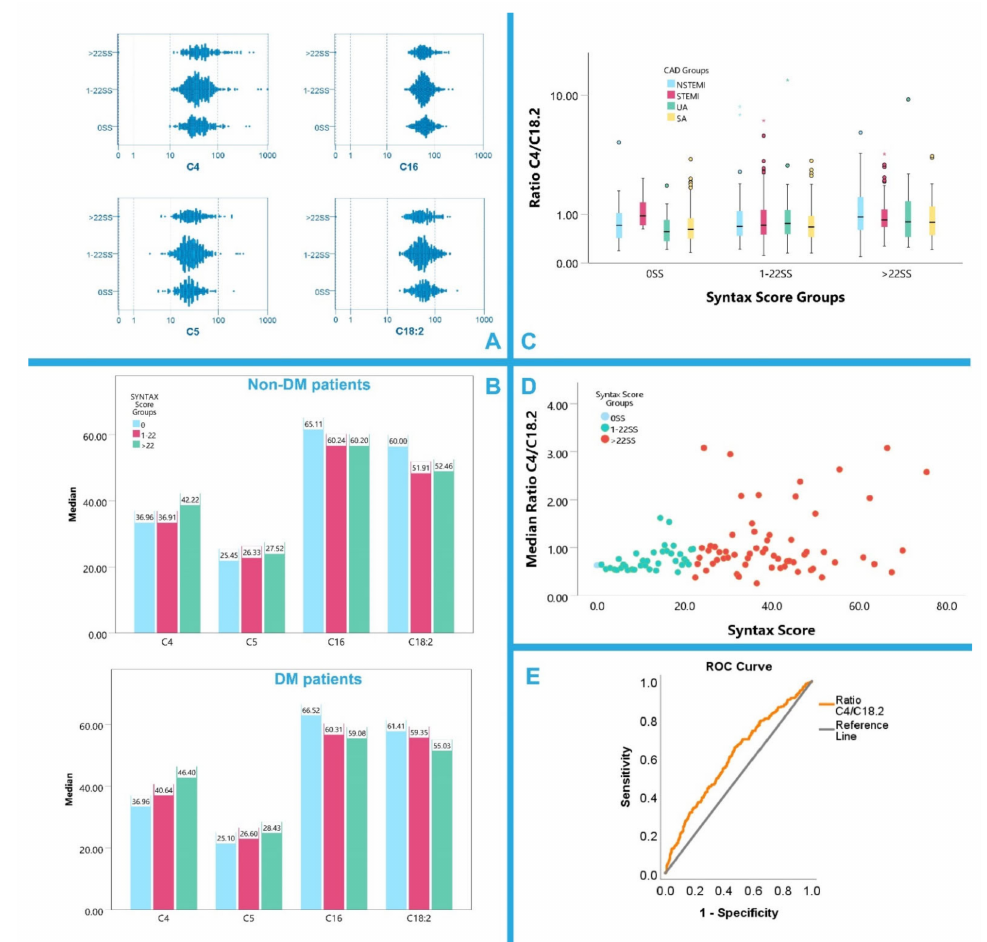
Figure 2. ( A ) SS Groups, log10 scaled 2-D plots for C4, C5, C16, and C18:2 level distributions. ( B ) Bar plots with the respective medians for each of the important acylcarnitines for the SS groups. ( C ) Log10 scaled grouped box plots with the respective medians for the C4/C18:2 carnitine ratio in each of the CAD groups for all three SS groups. ( D ) Linear relationship of the C4/C18:2 ratio to the continuous SS as identified by the linear regression model presented in text. ( E ) ROC analysis of the C4/C18:2 ratio for high risk SS Group >